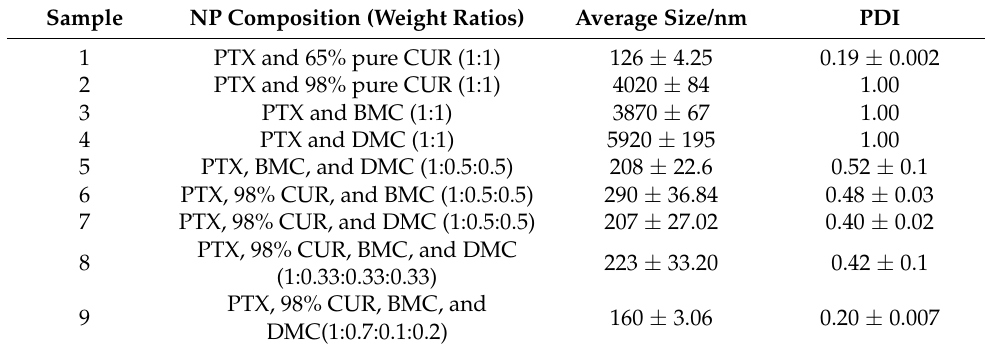
Table 3. The hydrodynamic diameter of the NPs obtained from different drug formulations measured by DLS. The weight ratios are stated in relative to PTX. PTX, CUR, BMC, and DMC stand for paclitaxel, curcumin, bisdemethoxycurcumin, and demethoxycurcumin, respectively.